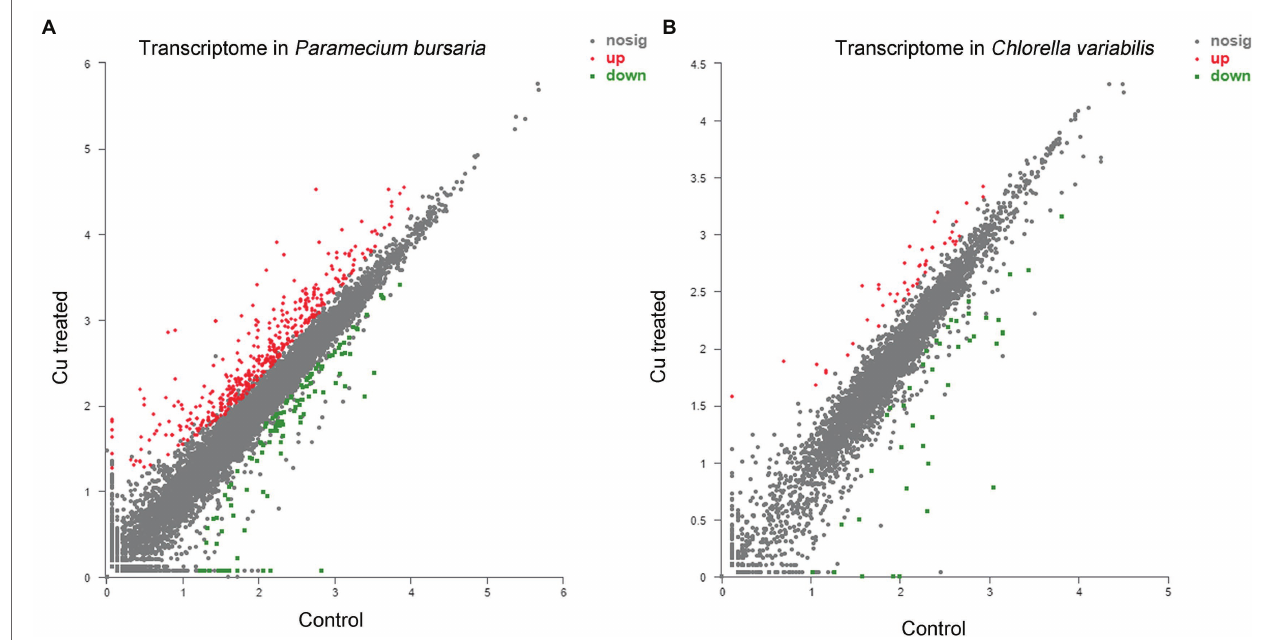
FIGURE 4 | Transcriptome analysis of P. bursaria (A) and Chlorella variabilis (B) under control and under CuNP treatment. Each dot represents an individual gene; differentially expressed genes are depicted according to microarray probe signal values. Red dots represent the significantly upregulated genes, and green dots represent the significantly downregulated